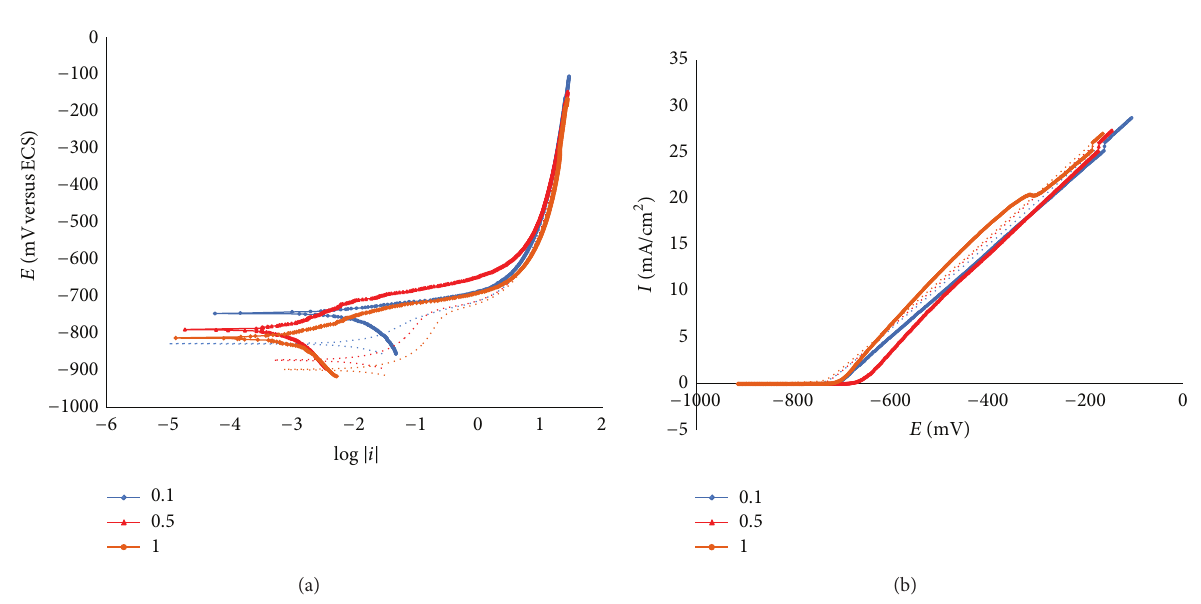
Figure 4: Polarization curves (a) and voltammograms (b) for aluminum conversion layers in cerium bath (0.1g L −1 ) at different concentrations of accelerator (boric acid); 0.1, 0.5, and 1g L −1 . Evaluated in NaCl 3.5% wt. aqueous